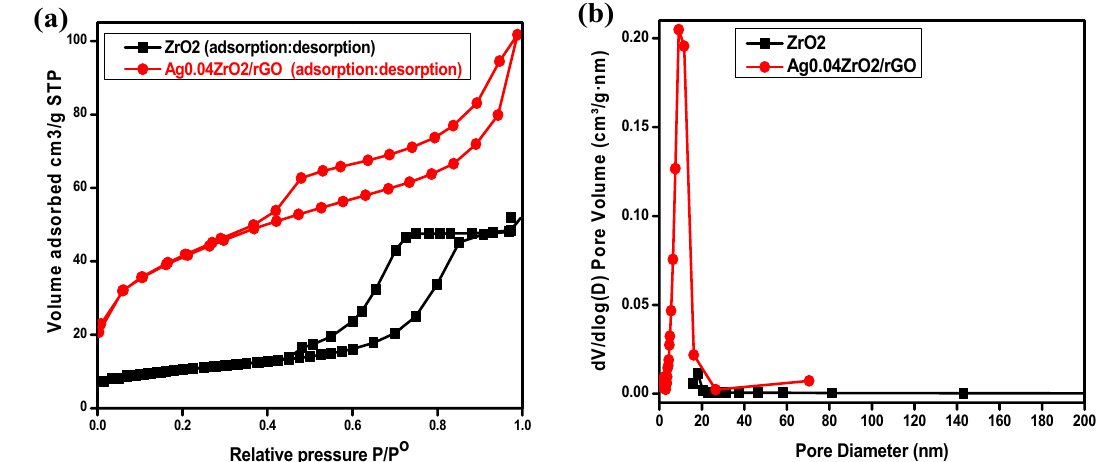
Figure 5. (a ) Adsorption desorption isotherm for ZrO 2 and Ag 0.04 ZrO 2 /rGO, ( b ) pore volume and pore diameter of the as prepared pure ZrO 2 and the composite Ag 0.04 ZrO 2 /rGO.